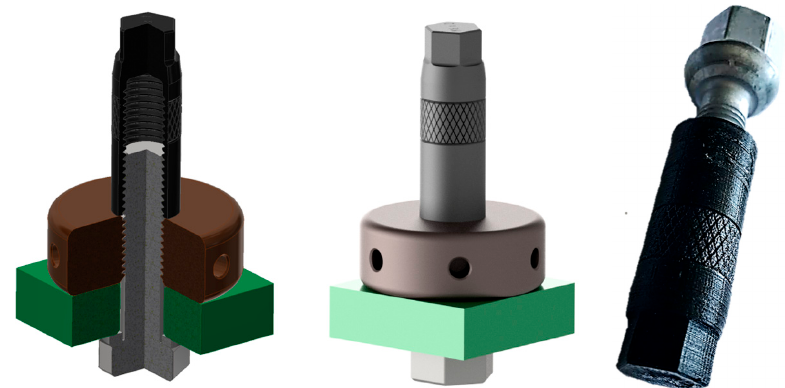
Figure 18. From the left: a 1/4-section view and a full view of assembly showing the essence of the protective cap. Photo of an FDM-printed cap mounted on a bolt.